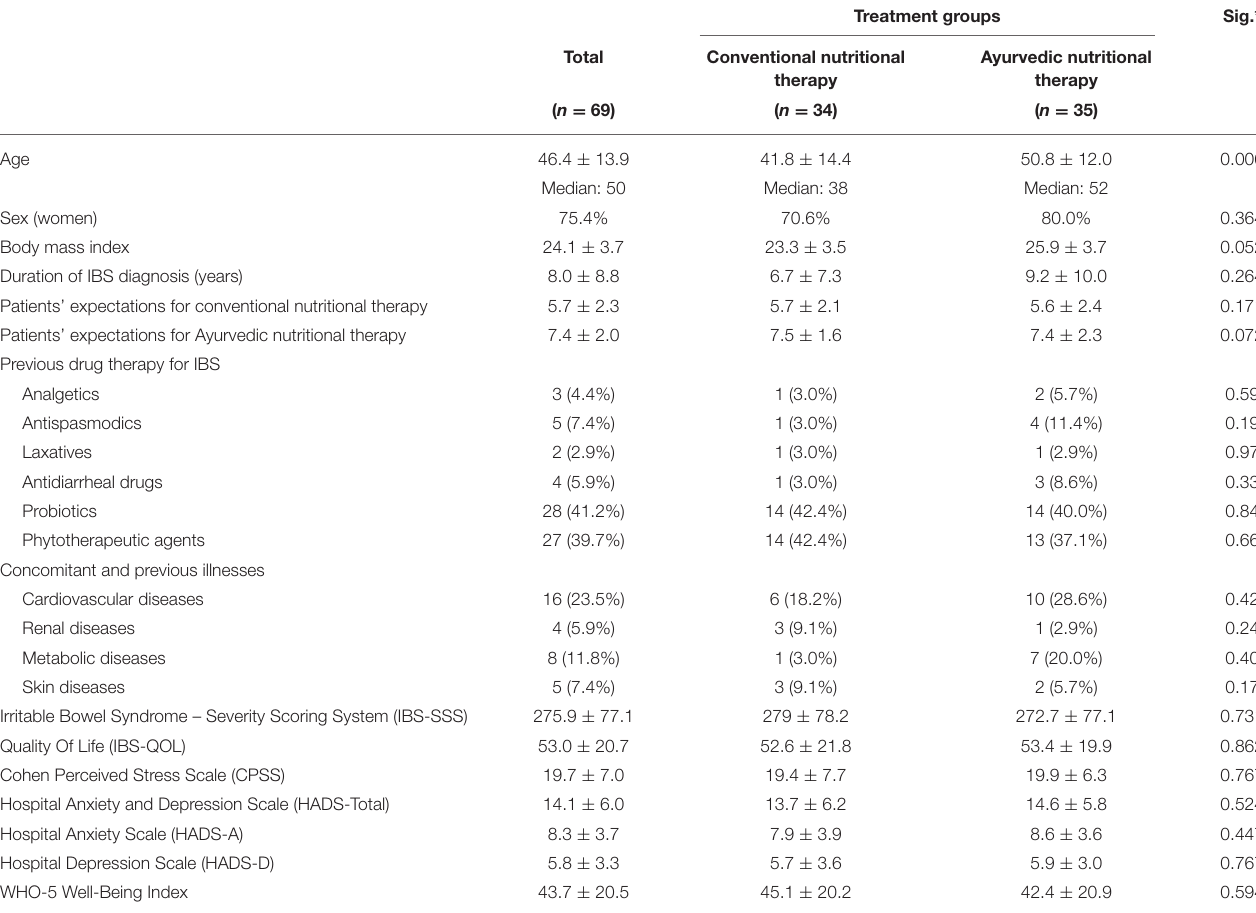
TABLE 1 | Baseline